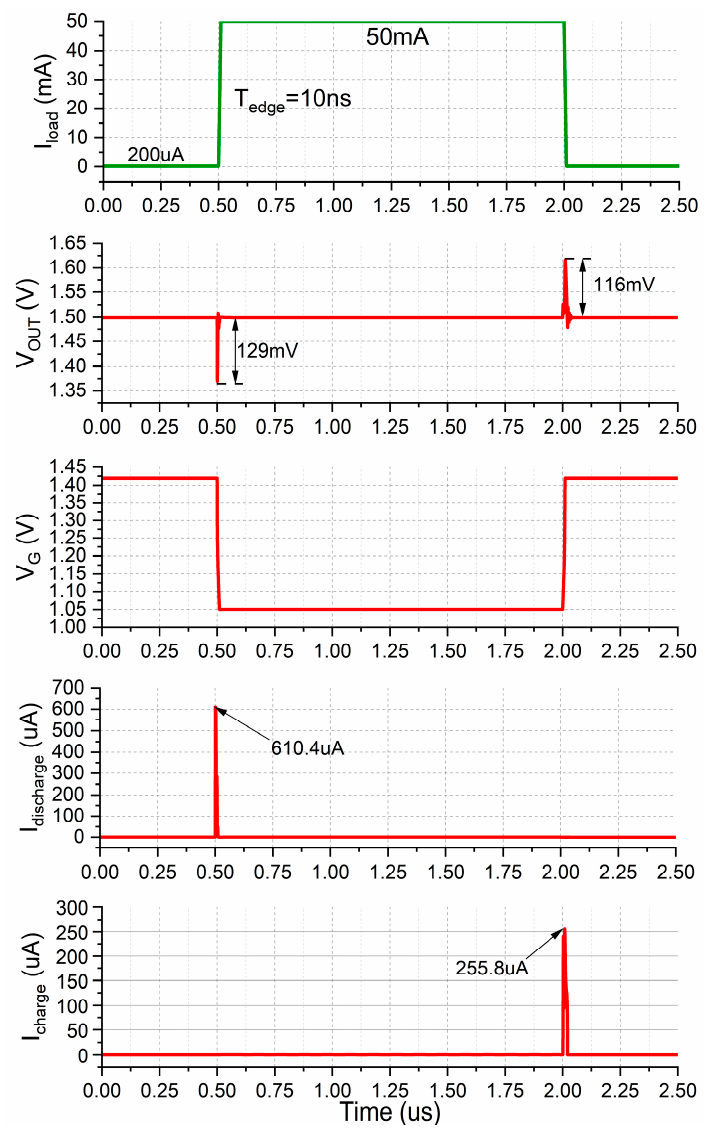
Figure 12. Simulated load transient response of OCL-LDO and the charge/discharge current when V OUT is overshoot/undershoot and the voltage of the gate of power transistor V G.